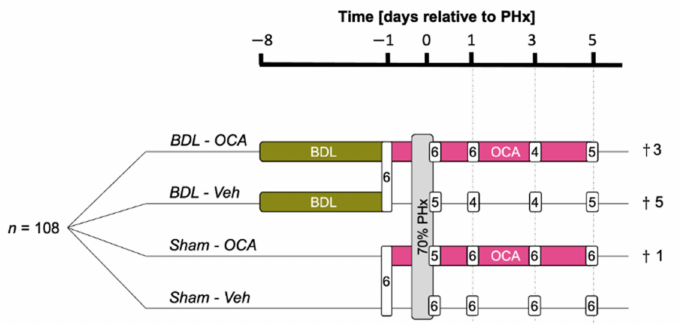
Figure 1. Study design. rBDL, reversible bile duct ligation; Sham, sham surgery; OCA, obeticholic acid; Veh, vehicle; PHx, partial hepatectomy. n indicates the number of rats sacrificed at the indicated time point. † refers to animal